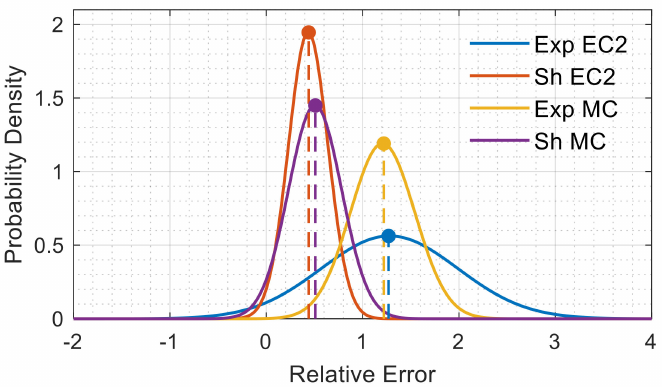
Figure 10. Normal distribution relative error curves between the experimental and shrinkage-free tension stiffening values versus their EC2 and MC2010